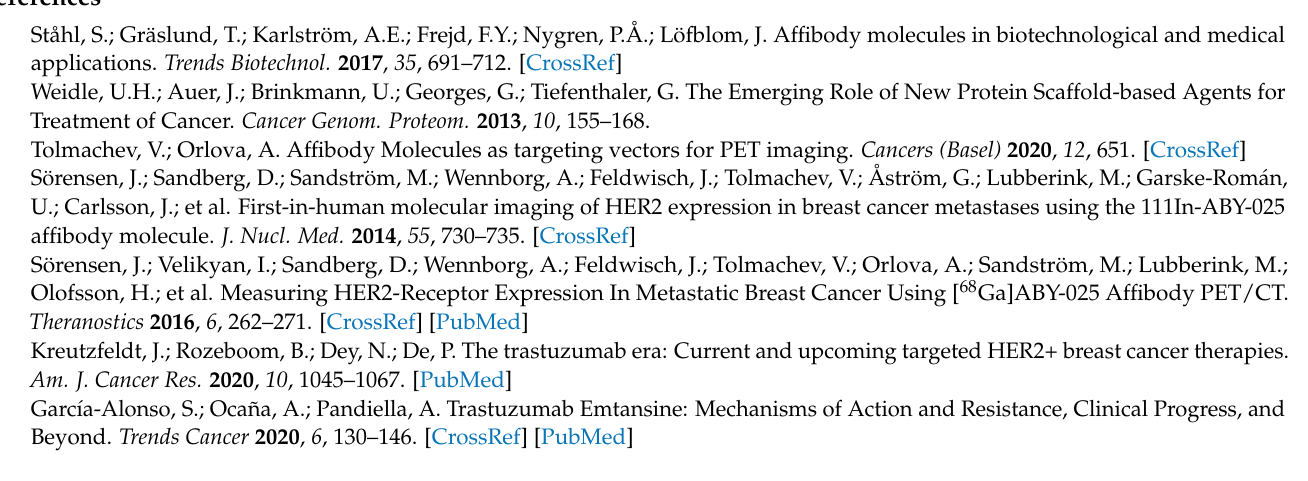
incubation with labeled compounds. Figure S15: Ex vivo autoradiography of tumor slices from the pretargeting experiment 4 h after injection. Figure S16: Ex vivo autoradiography of tumor slices from the pretargeting experiment 144 h after injection. Figure S17: Time-activity plots for [ 177 Lu]Lu- HP16